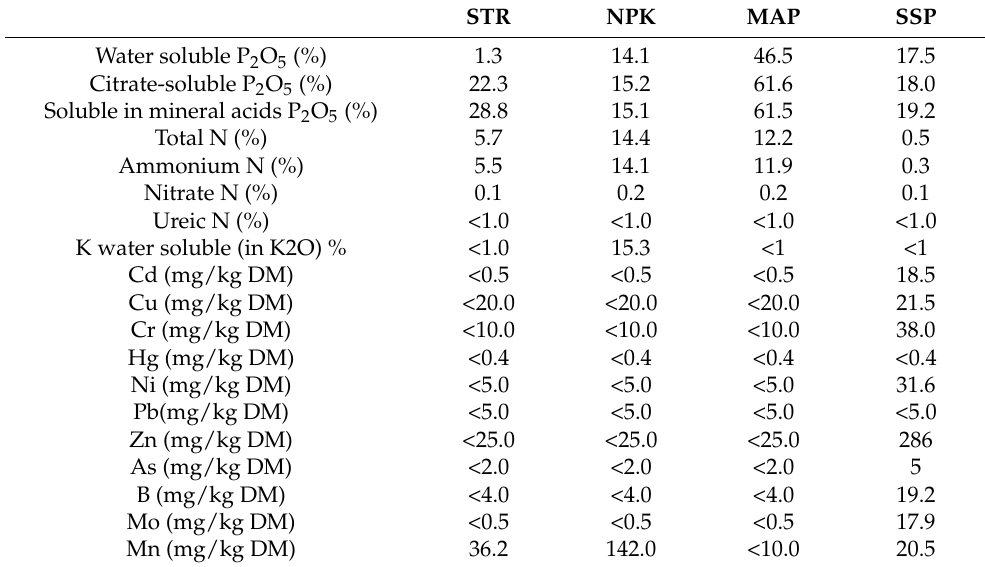
Table 2. Main physicochemical characteristics and heavy metals content of the fertilizers.